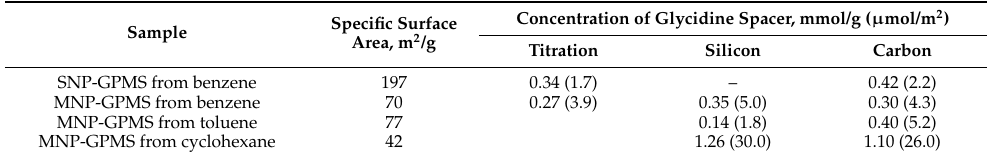
Table 1. SNP and MNP properties after GPMS chemisorption.